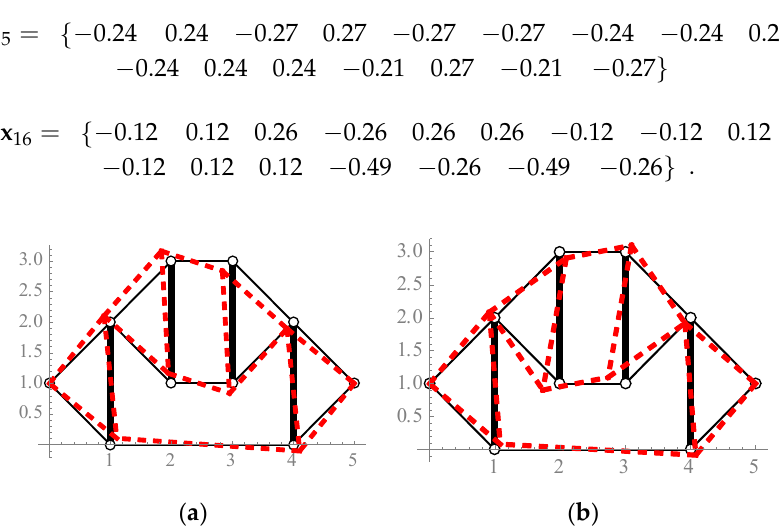
Figure 7. Infinitesimal mechanisms of the second pure tensegrity truss: ( a ) 𝐱 (cid:2869)(cid:2873) , ( b ) 𝐱 (cid:2869)(cid:2874) .